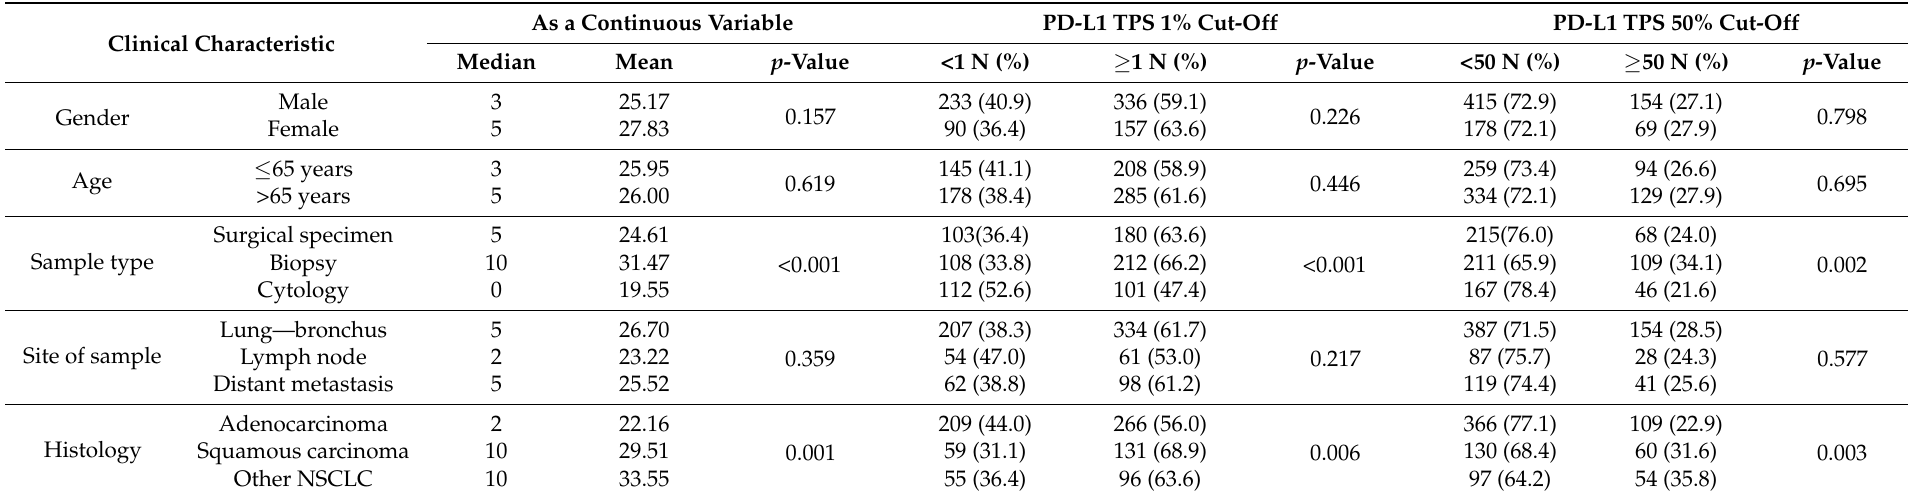
Table 2. PD-L1 result of samples acquired at our institution (N = 816) with different types of measurements: as a continuous variable, and as a dichotomous variable (both with cut-off points TPS 1% and TPS